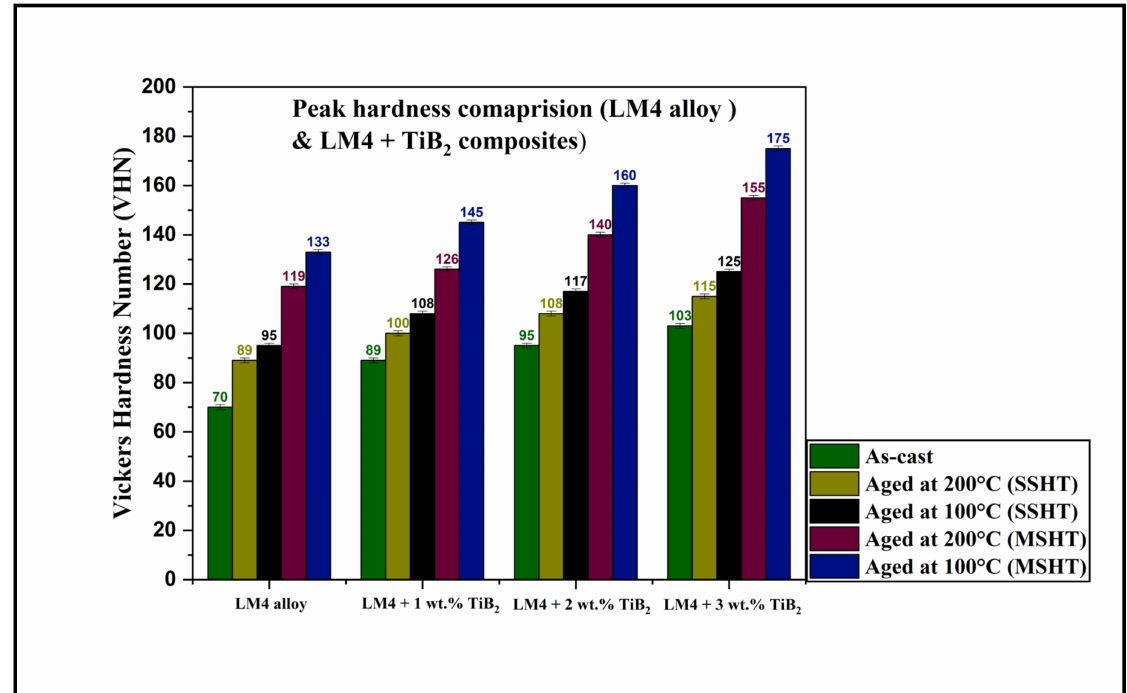
Figure 14. Comparison of the peak hardness of the LM4 alloy and its composites under different solutionizing and aging